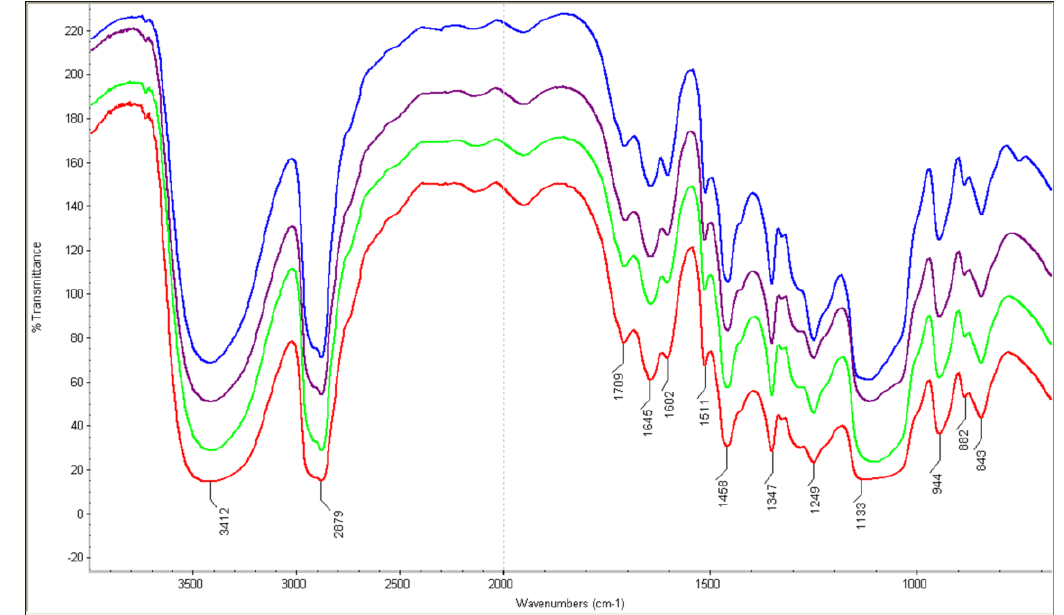
Figure 1. FT-IR spectra of all of the liquefied products.